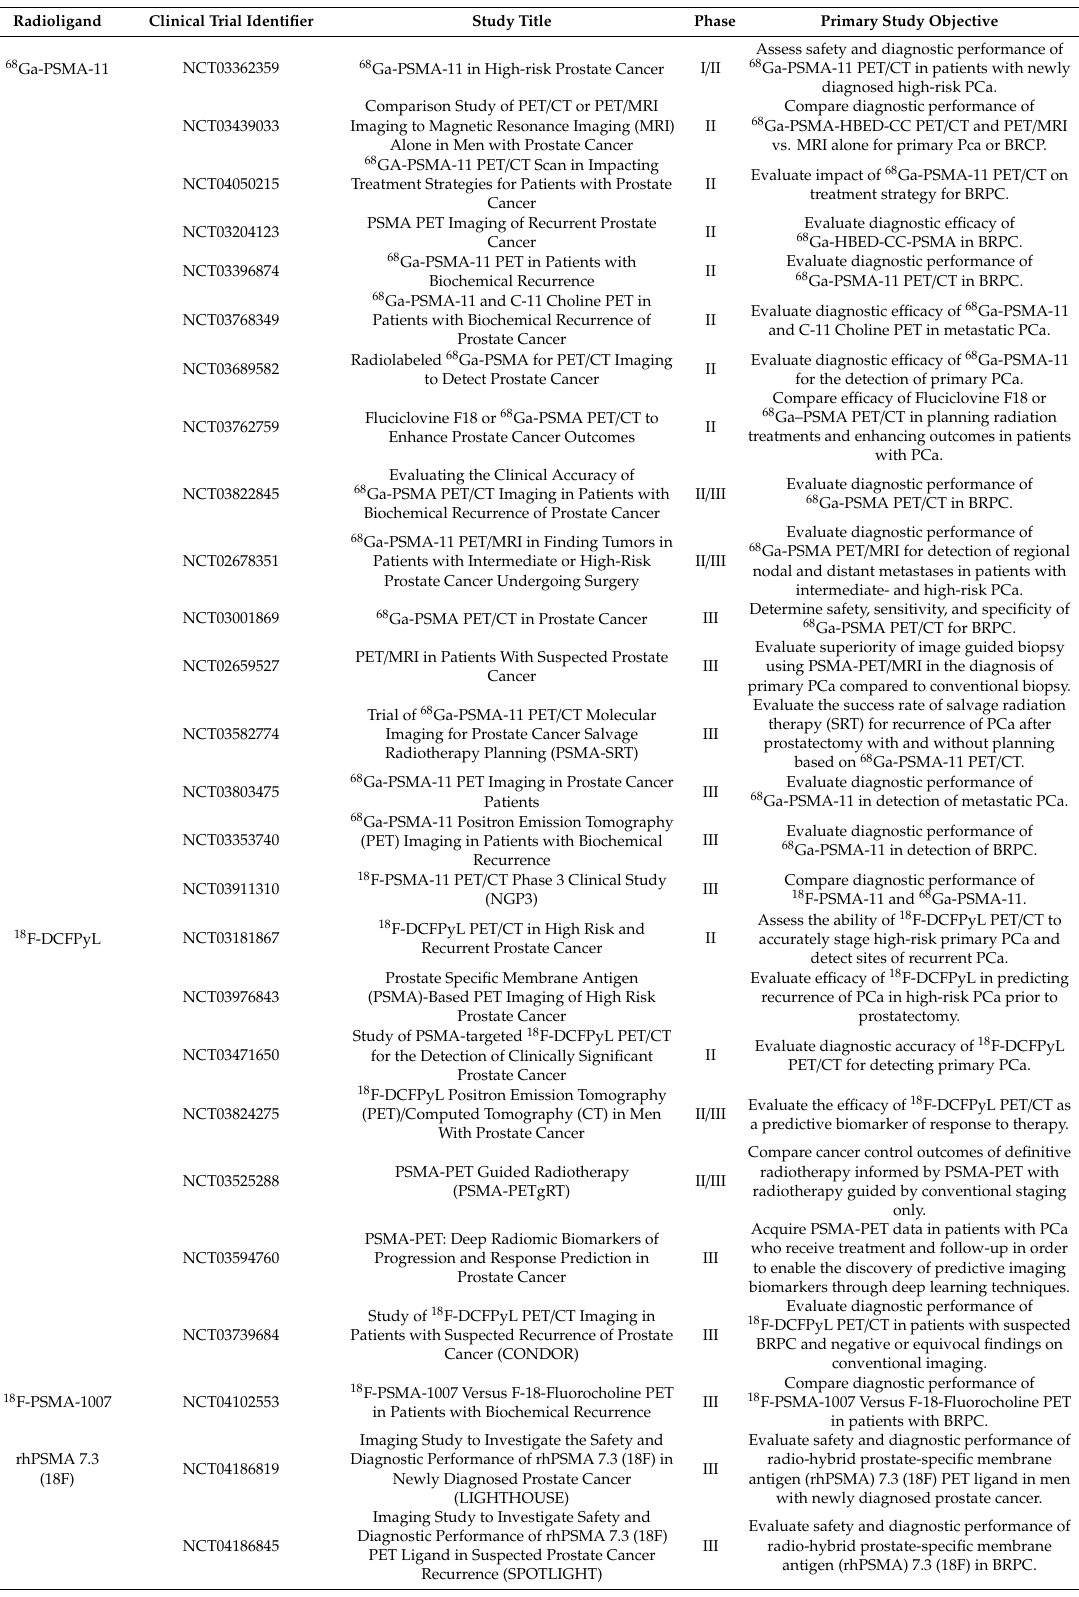
Table 1. Ongoing Phase II and III clinical trials of PSMA-based imaging with enrolment of at least 100 participants.